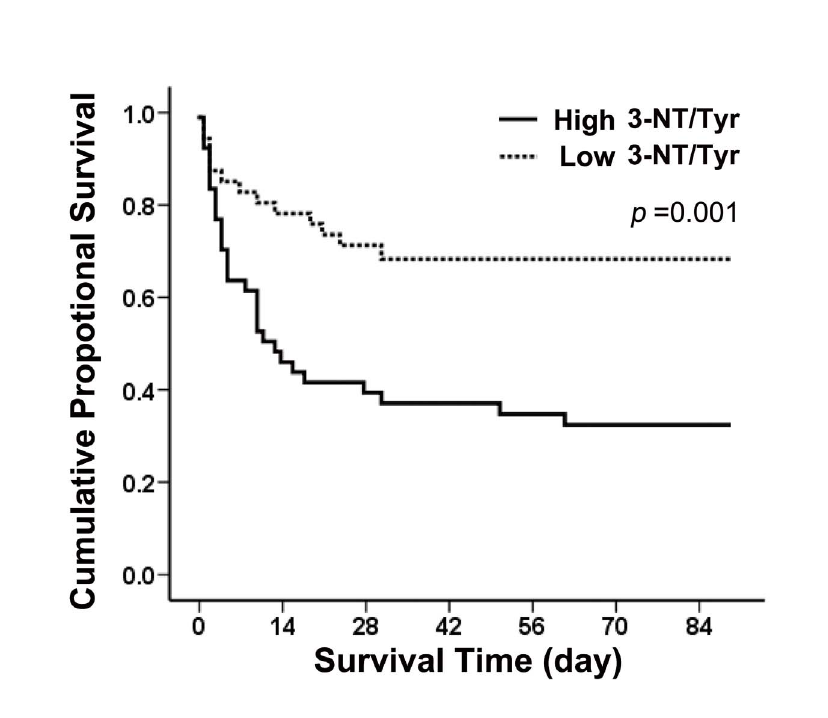
Figure 4. Kaplan-Meier analysis for the cumulative percentage of surviving patients at 90 days according to different 3-NT/Tyr. Kaplan-Meier plots for probability of survival at 90 days between high and low 3-NT/Tyr. Significant difference between the two subgroups was found (log rank p =0.001).